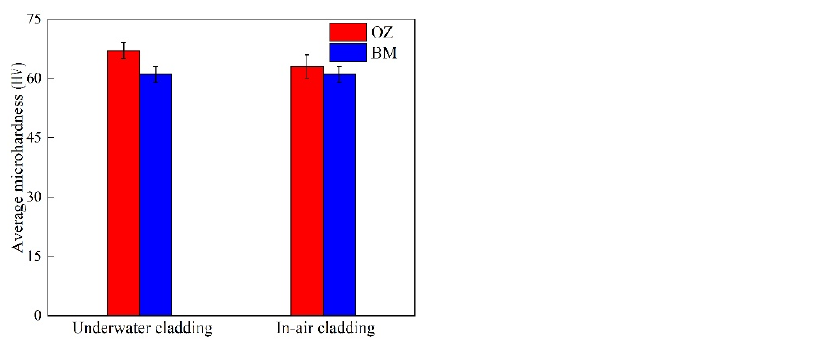
Figure 13. The microhardness distribution in different zones of underwater and in-air cladding lay- ers.